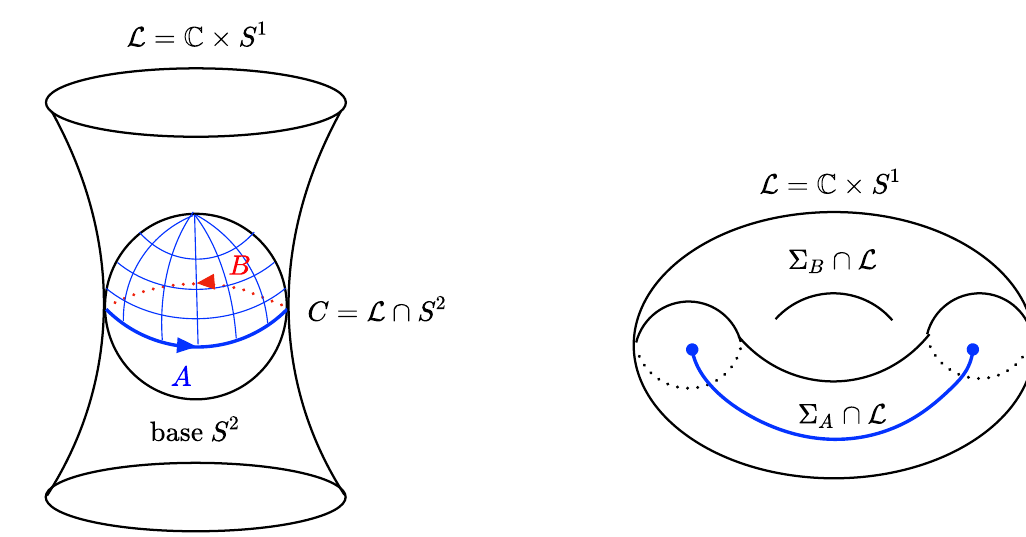
Figure 5 . On the left, we show the splitting of the worldsheet boundary into A and B . On the right, the brane L on which the closed string configurations X ( σ ) live is split into subregions by the entanglement branes. We show an open string configuration X ij ( σ ) ∈ F Σ entanglement branes intersecting L along two open